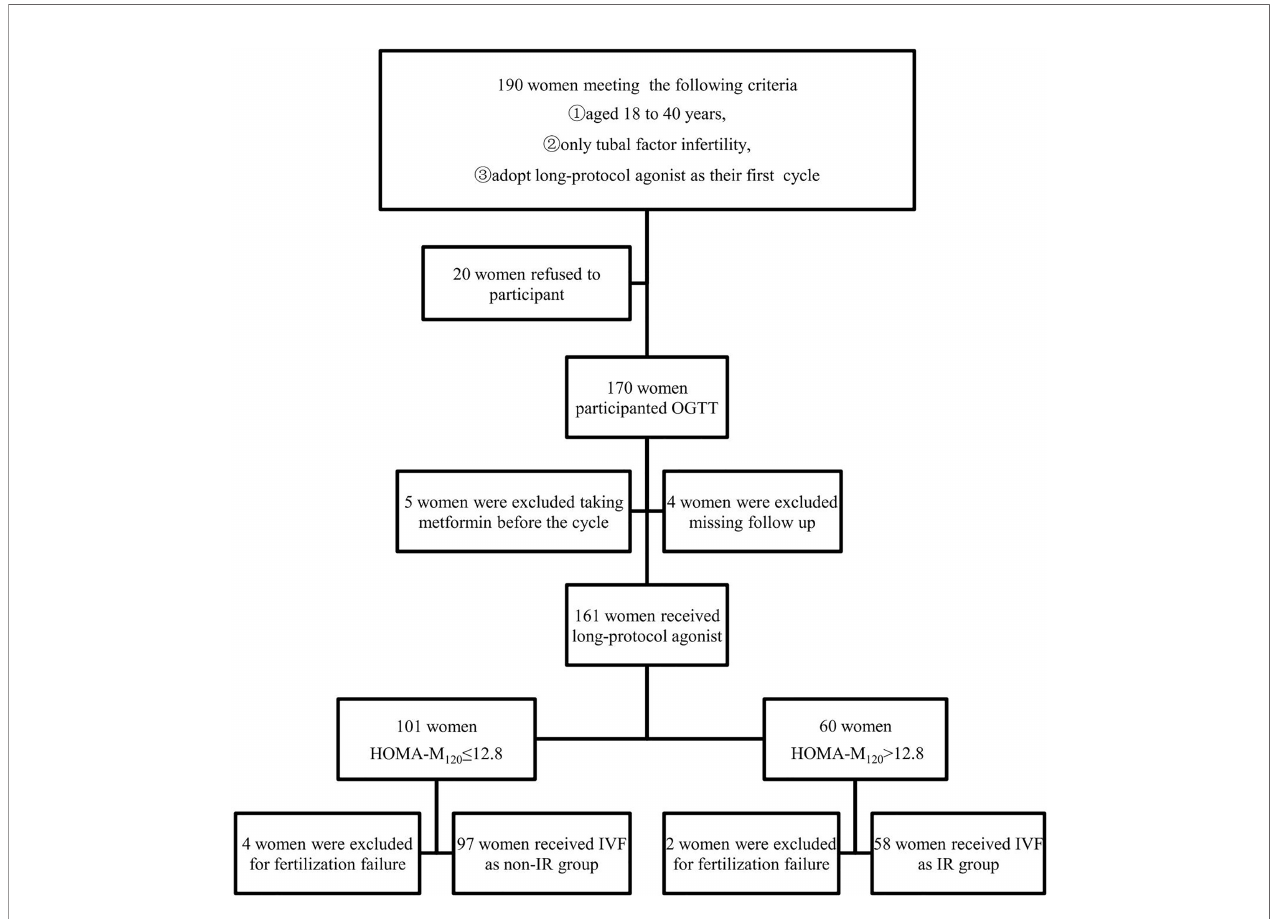
FIGURE 1 | Flow diagram of literature